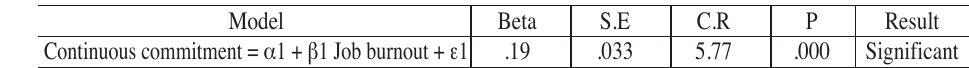
Organizational Commitment and Turnover Intentions